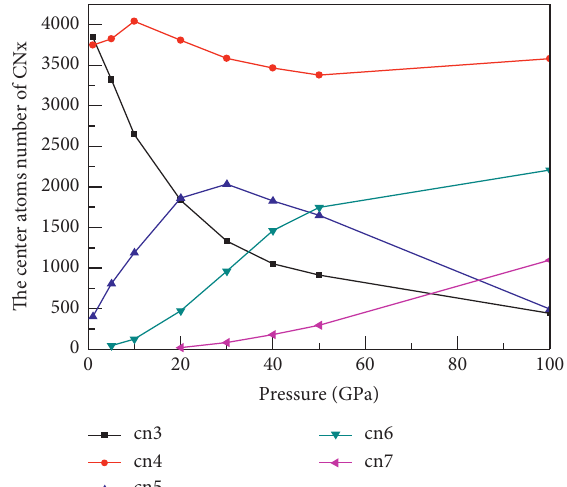
Figure 12: Pressure-dependent variation in the number of central atoms with different CN in amorphous SiC (100K).